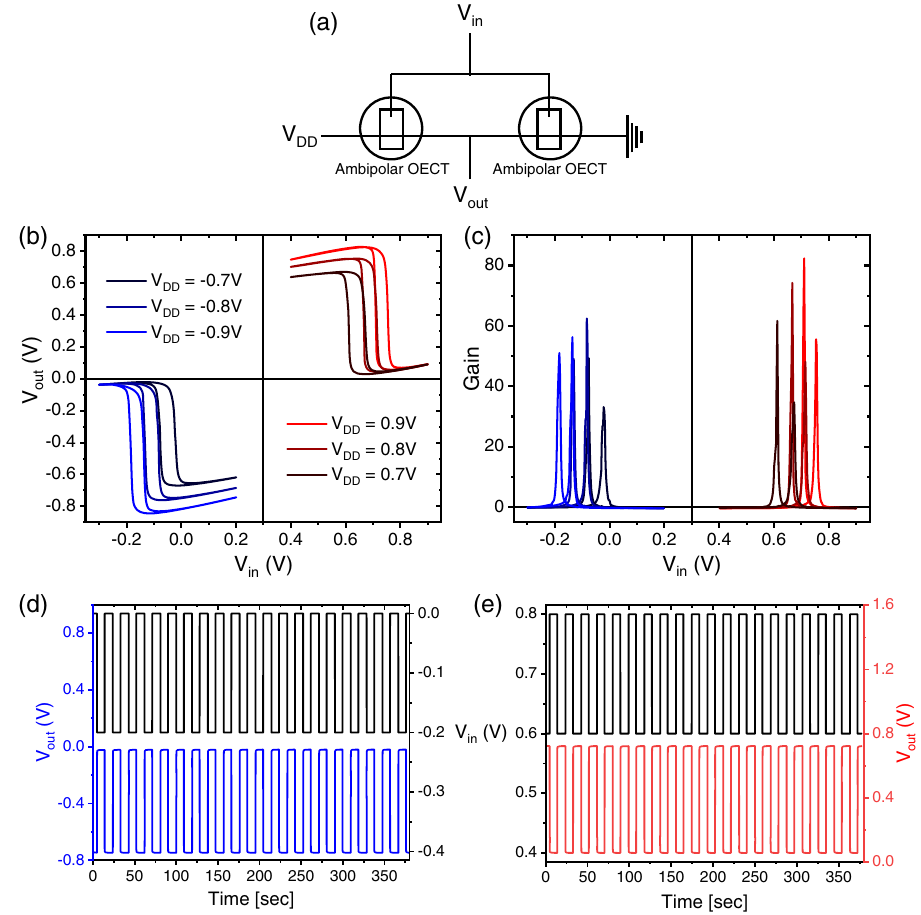
Fig.4|Ambipolar-basedInvertercharacteristics.a Wiringdiagramofaninverter consisting of two identical ambipolar OECTs connected in series, one grounded andtheotherconnectedtoV DD ,withacommongateelectrodeapplyingV in andan outputvoltageV out .TherangeforV in wasselectedtobethesameasV G oftheblend OECTpresentedinFig.1. b VoltageTransferCharacteristics(VTC),showingactivity in both quadrants centering around V in =+0.3V at a voltage scan rate of 0.1V/sec;